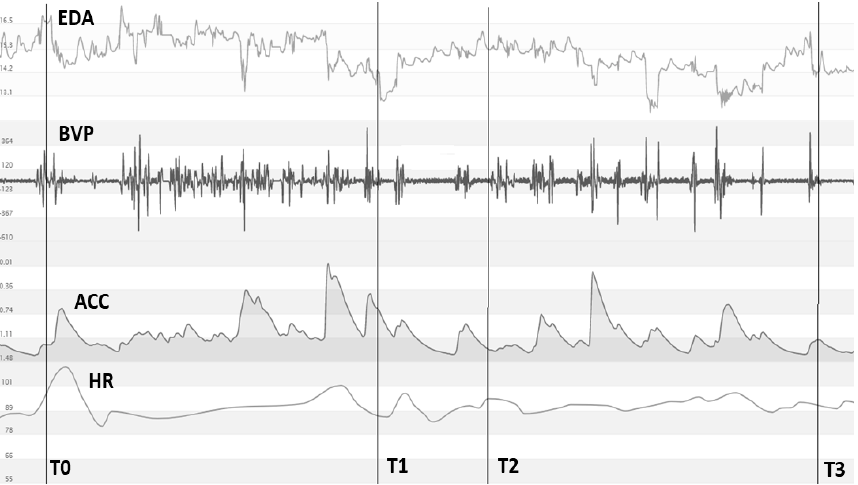
Figure 5. Biometric parameters during disturbance factor. EDA—Electro-Dermal activity, EDA—Electro-Dermal activity, BVP—Blood-Volume pulse, ACC—wrist acceleration, HR—Heart-Rate. T0—beginning of the